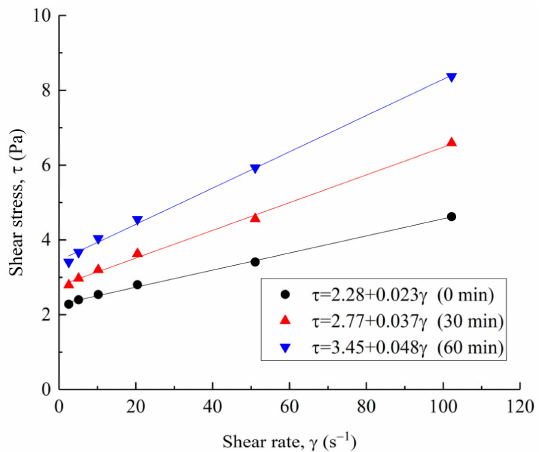
Figure 5. Typical rheological curves of fresh UC-based slurry